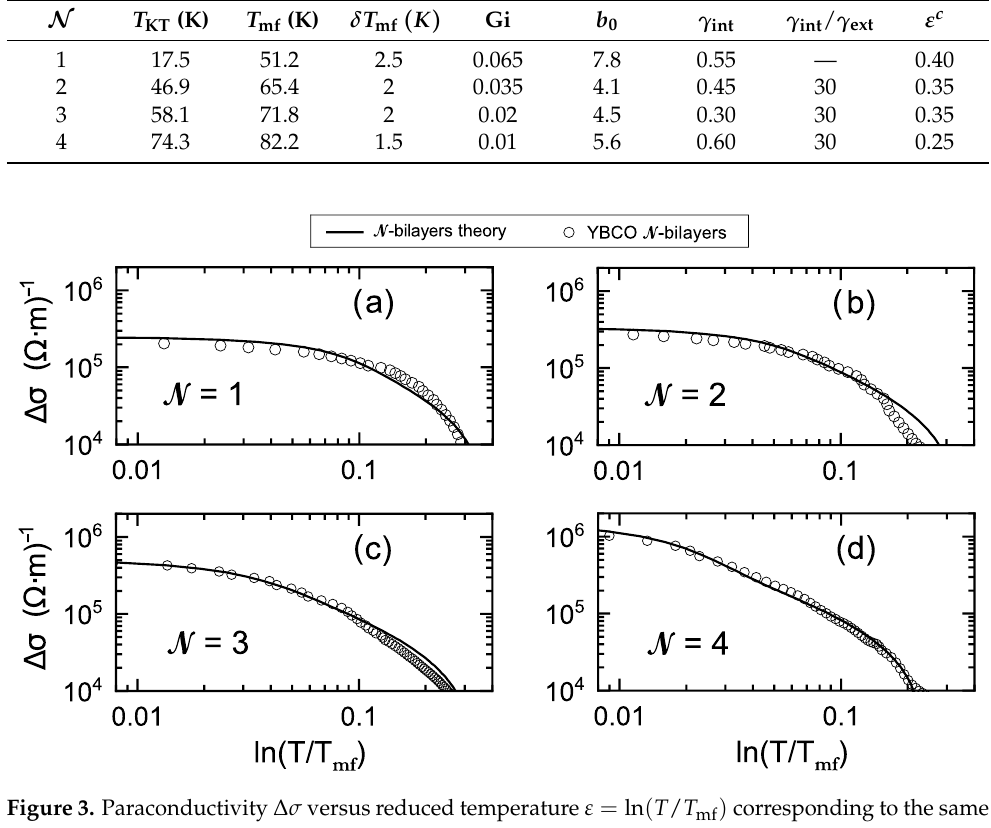
Figure 3. Paraconductivity ∆ σ versus reduced temperature ε = ln ( T / T mf ) corresponding to the same data [18] as in Figure 2 (open circles) for samples with ( a ) N = 1, ( b ) N = 2, ( c ) N = 3 and ( d ) N = 4 unit cells of superconducting bilayers of YBa 2 Cu 3 O 7 − δ and also the same theory predictions and parameter values as in that Figure (solid lines). This representation is the more usual one in the literature when studying ∆ σ above the transition. Our proposed scenario for the critical fluctuations in few-bilayers HTSC are in good agreement with the experimental data also in this